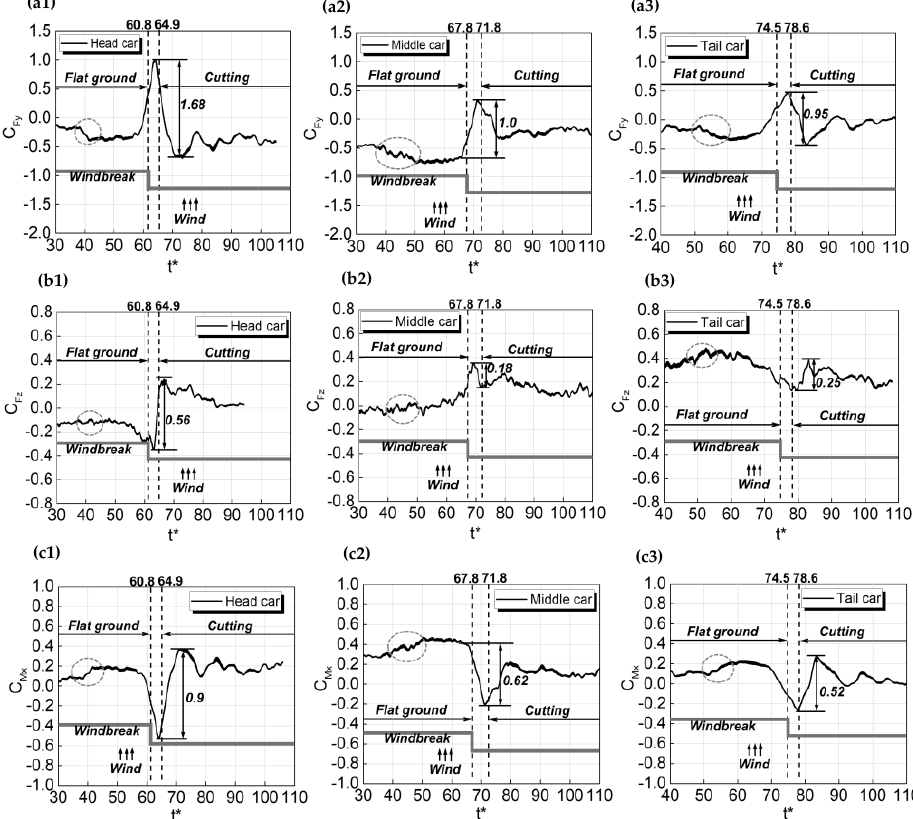
Figure 7. Aerodynamic forces and moment variation along the WT: ( a1 – a3 ) C Fy of head car, middle car and tail car, respectively, ( b1 – b3 ) C Fz of head car, middle car and tail car, respectively, and ( c1 – c3 ) C Mx of head car, middle car and tail car, respectively.